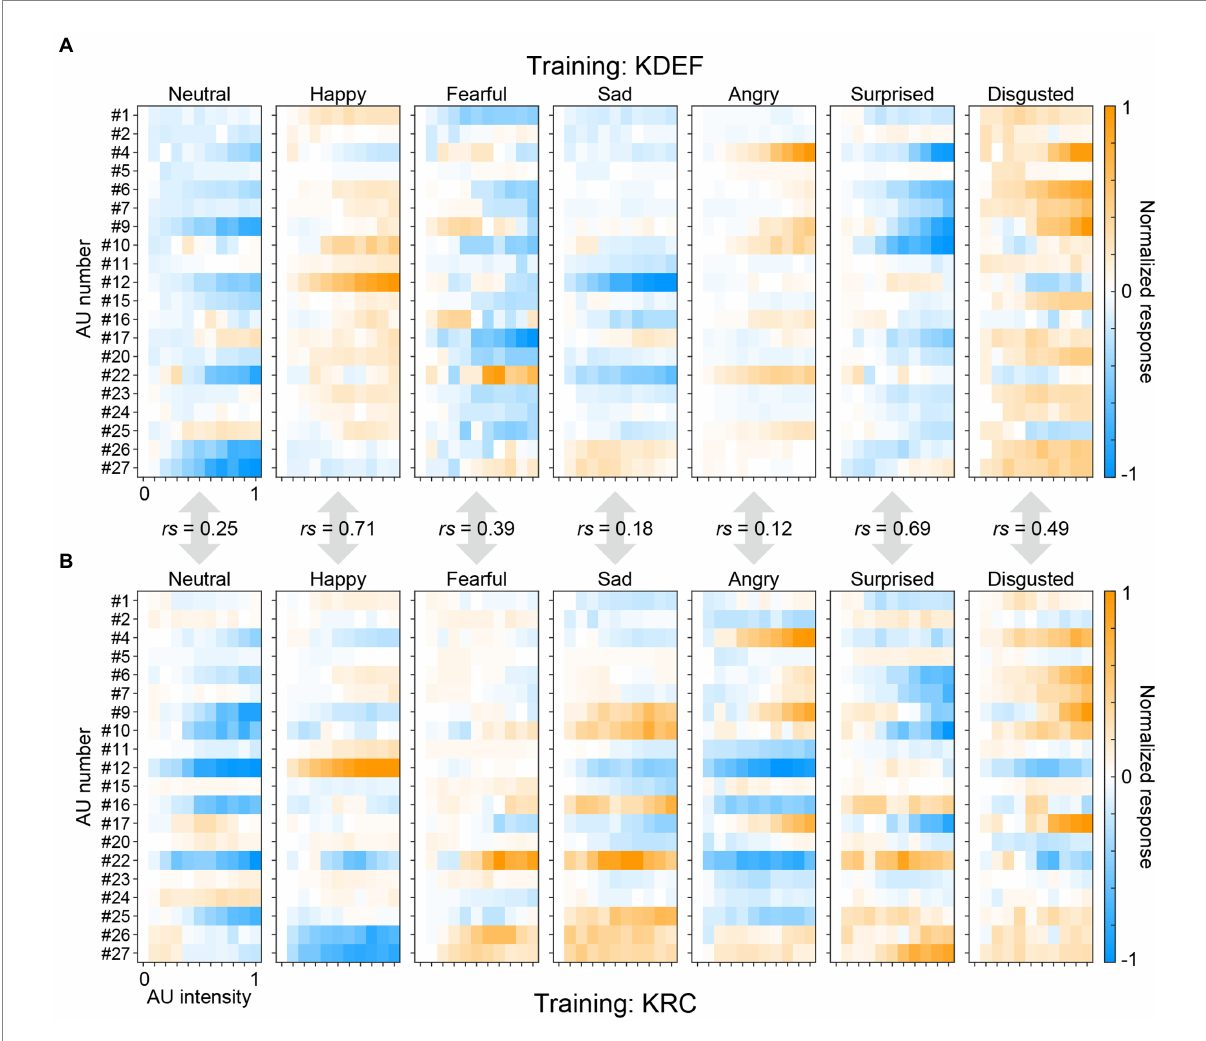
FIGURE 7 Full response profiles of the selectivity to 20 AUs. The response profiles of the seven computational units in the FC3 layer are shown for the KDEF- trained CNNs (A) and the KRC-trained CNNs (B) . The mean responses averaged across 40 runs are coded by color (scale bar to the right). In each panel, the responses are normalized so that the maximum absolute value of the entire profile becomes 1. Spearman’s rank correlation coefficients are shown for each of the seven computational